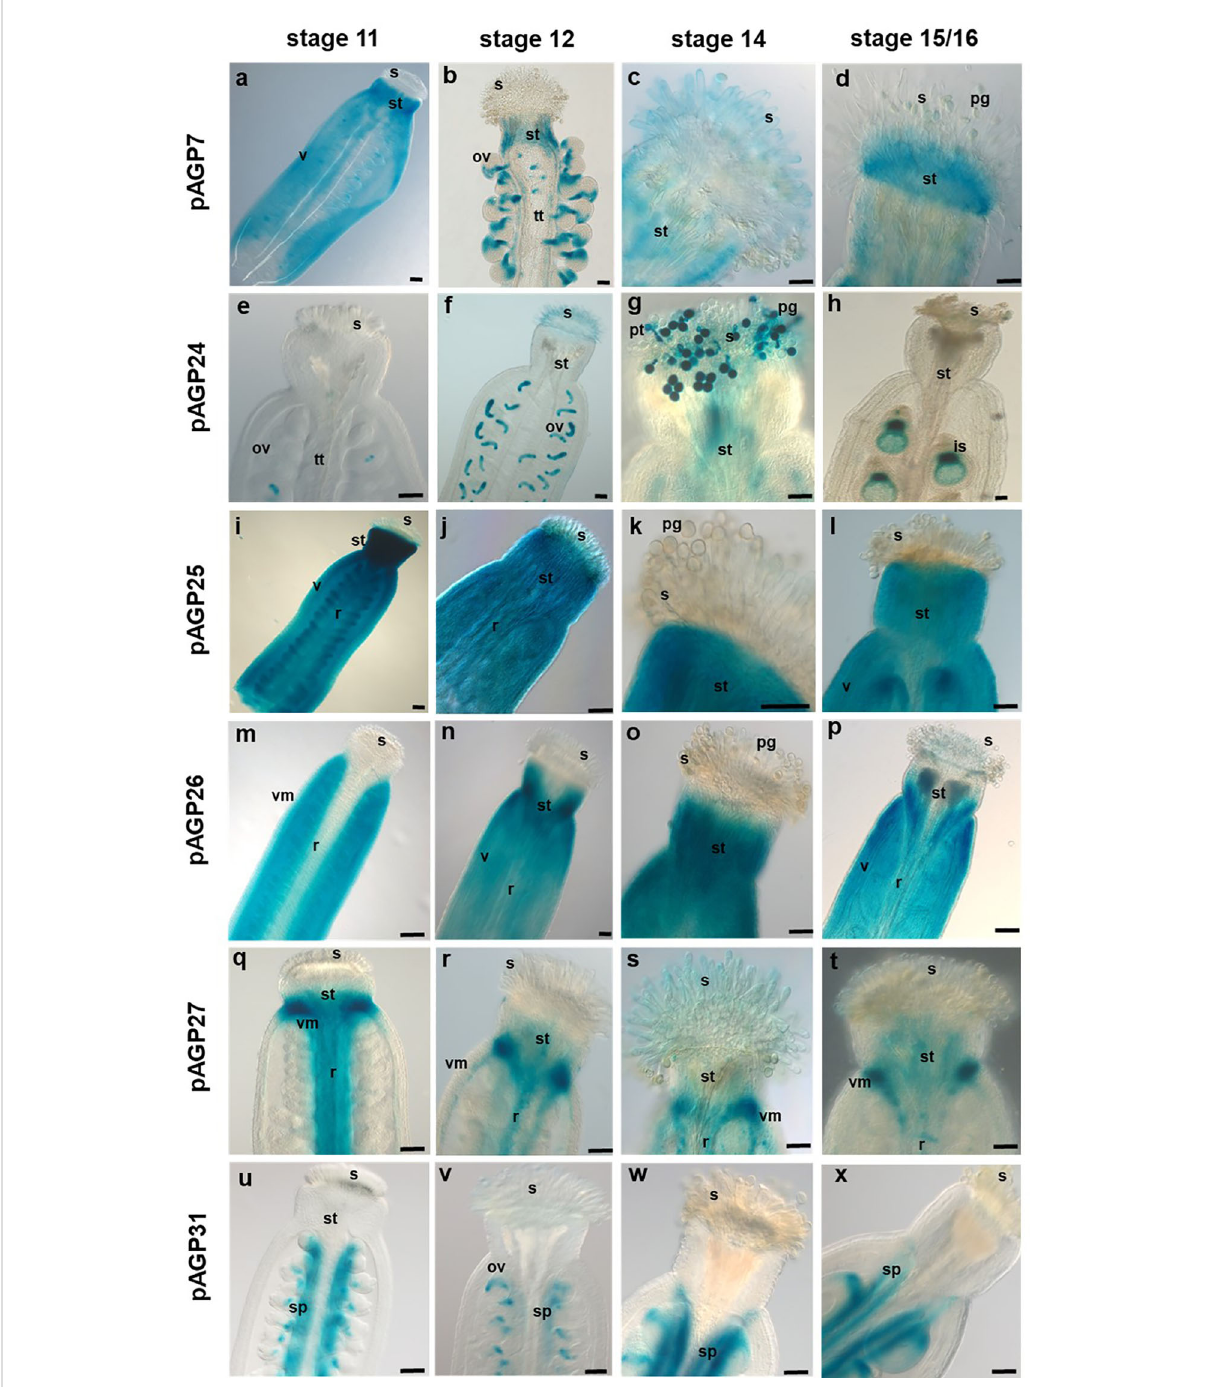
FIGURE 2 Histochemical localization of GUS activity in transgenic Arabidopsis pistils expressing different pAGP : GUS fusion constructs. (A – D) GUS activity driven by the AGP7 promoter at different stages detected in the style (a-d), valves and stigmatic cells (C) . (E – H) GUS activity driven by the AGP24 promoter at different stages observed in the ovules (E, F, H) and pollen grains (G) . (I – L) GUS activity driven by the AGP25 promoter identi fi ed in pistil tissues, including the style, valves and replum. (M – P) GUS activity driven by the AGP26 promoter at distinct stages was observed in valves and style. (Q – T) GUS activity driven by the AGP27 promoter visible in the style, replum, valve margins, transmitting tract, and septum. (U – X) GUS activity driven by the AGP31 promoter at different stages visible in the septum and ovules. Flowers of stages 11, 12, 14 and 15/16 (Smyth et al., 1990) were used in this study. ov, ovule; pg, pollen grain; pt, pollen tube; s, stigma; st, style; sp, septum; tt, transmitting tract; vm, valve margin; v, valves; r, replum. Scale bars, 100 m m (A, B, F, H, I, N) ; 50 m m (C – E, G, J, L, M, O – V, W, X) ; 20 m m (F)